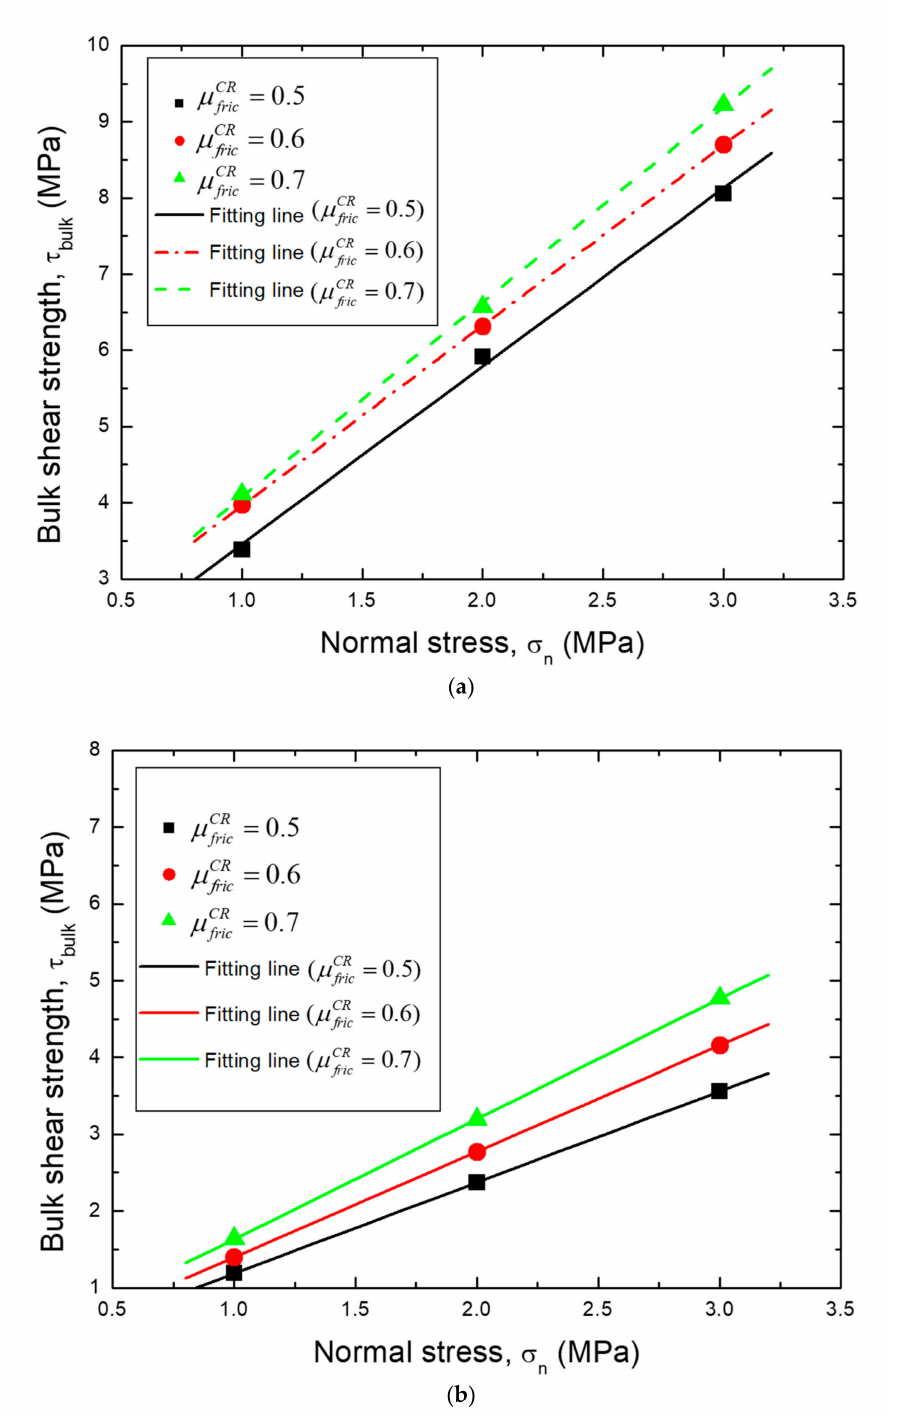
Figure 17. Linear fitting lines of various values of σ n (i.e., σ n = 1.0, 2.0, and 3.0 MPa) under di ff erent = 0.5, 0.6, and 0.7) based on the MC shear failure criteria with a relatively ( a ) rough joint µ CR ( µ CR fric fric ( α = 40 degrees) and ( b ) smooth joint ( α = 10